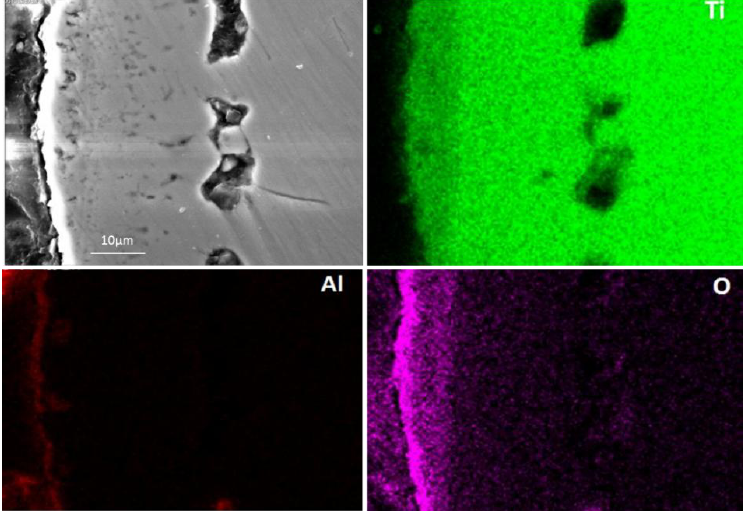
Figure 5. XRD pattern for cross-sectioned Ti heated up to 950 °C.